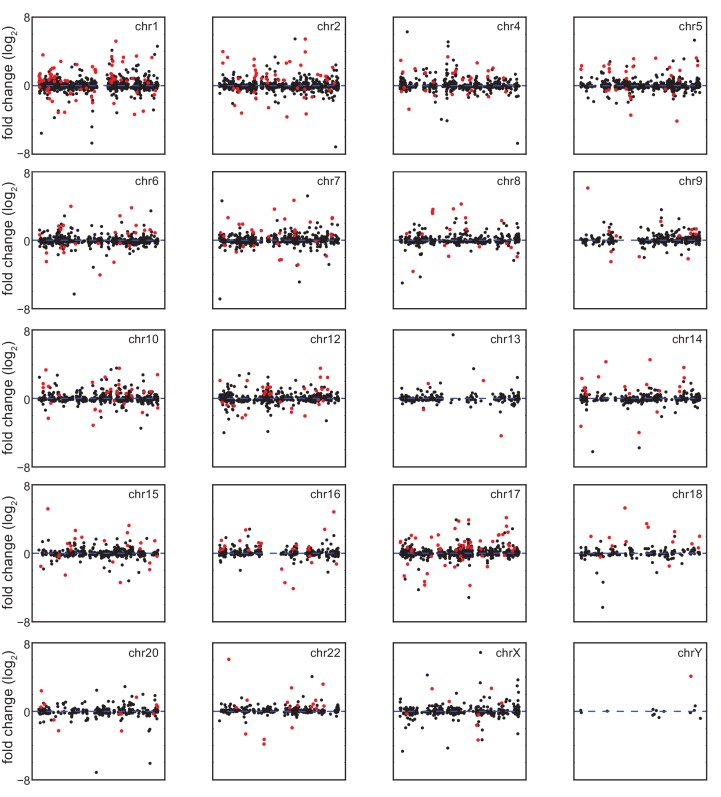
Differentially expressed genes in trisomy 21 fibroblasts are not organized into obvious chromatin domains.Manhattan plots for individual chromosomes indicating differentially expressed genes in red.